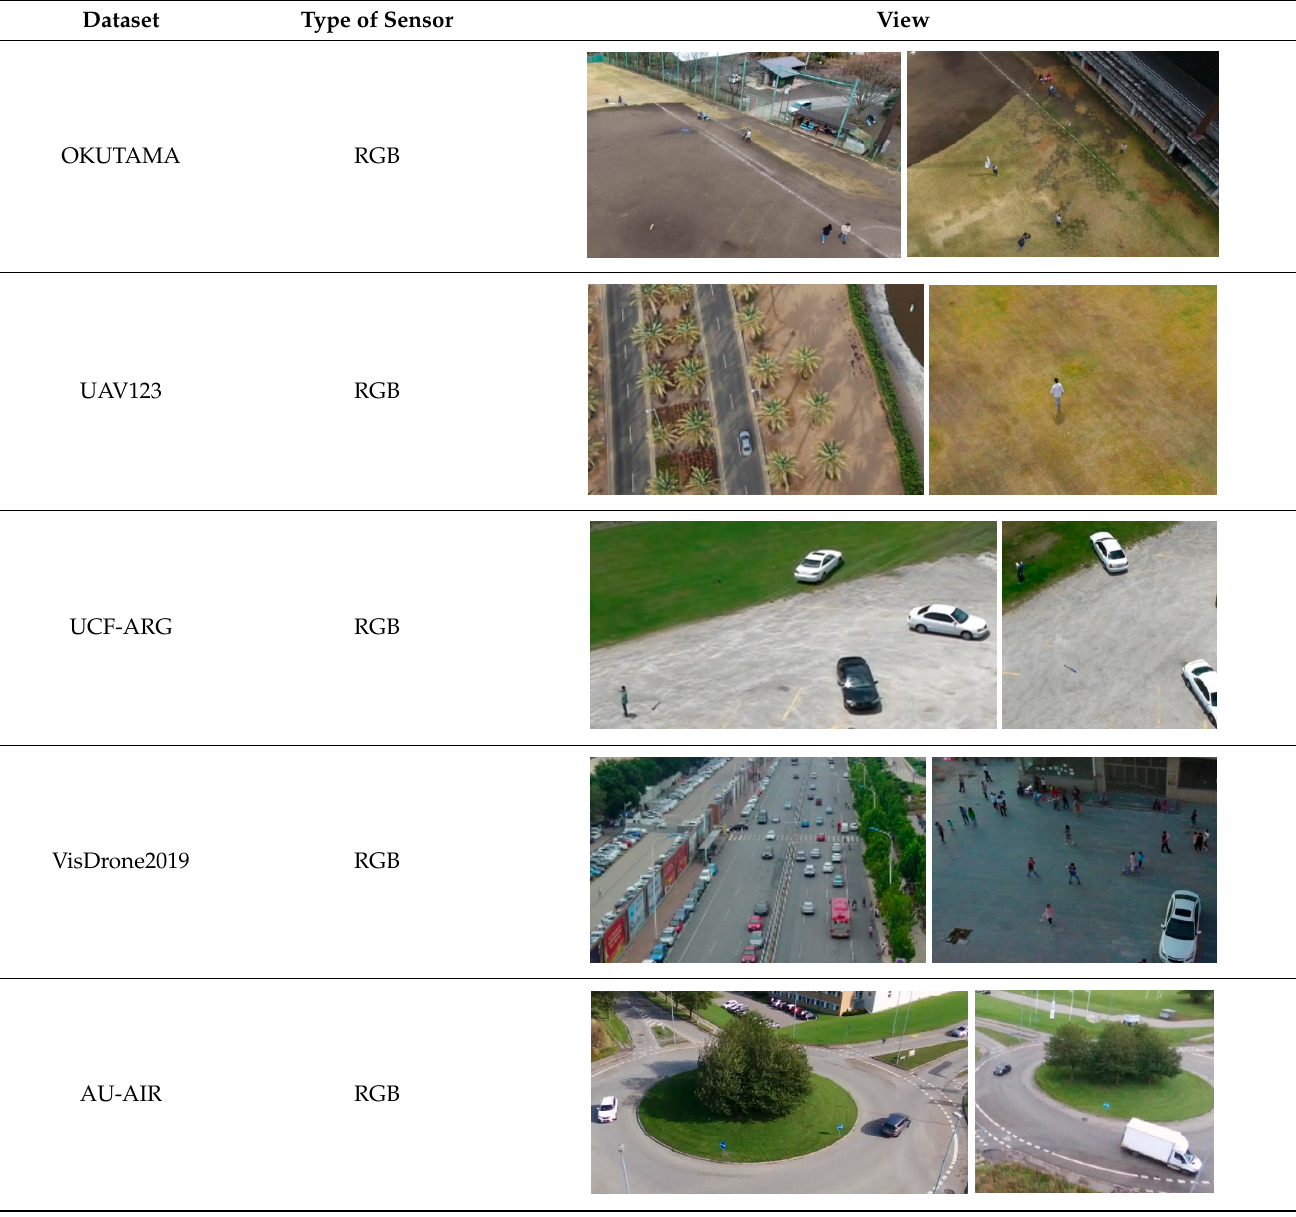
Figure 3. Example snapshot of the User Interface of the intelligence officer’s workstation on the OKUTAMA dataset.